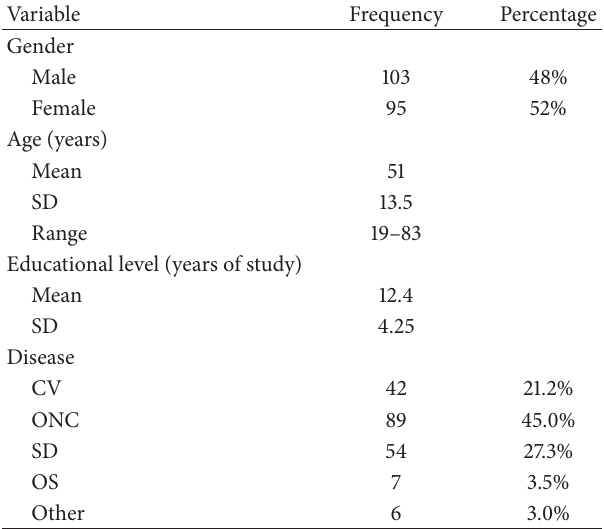
Table 1: Descriptive statistics of demographic and clinical